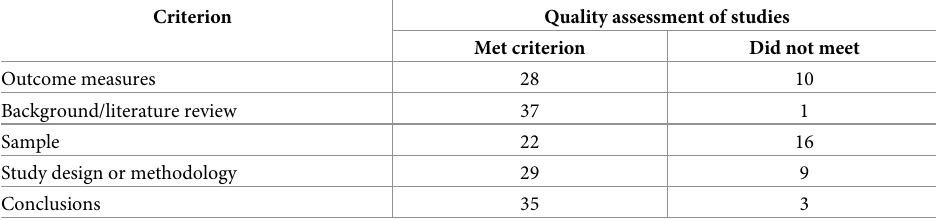
Table 4. A summary of quality appraisal, by